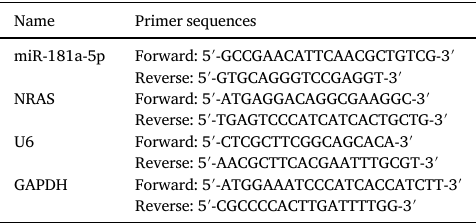
Table 1 The Polymerase Chain Reaction (PCR) primers used in this research